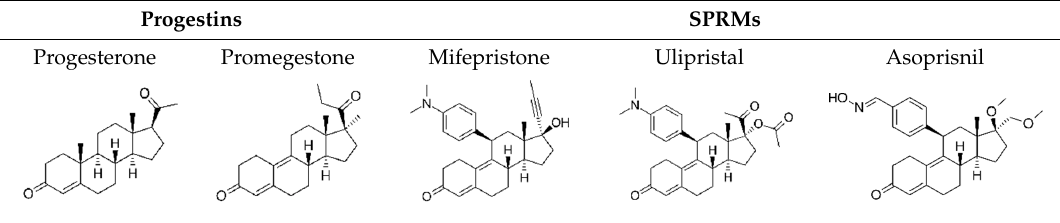
Table 1. Structure of tested progestins and SPRMs.